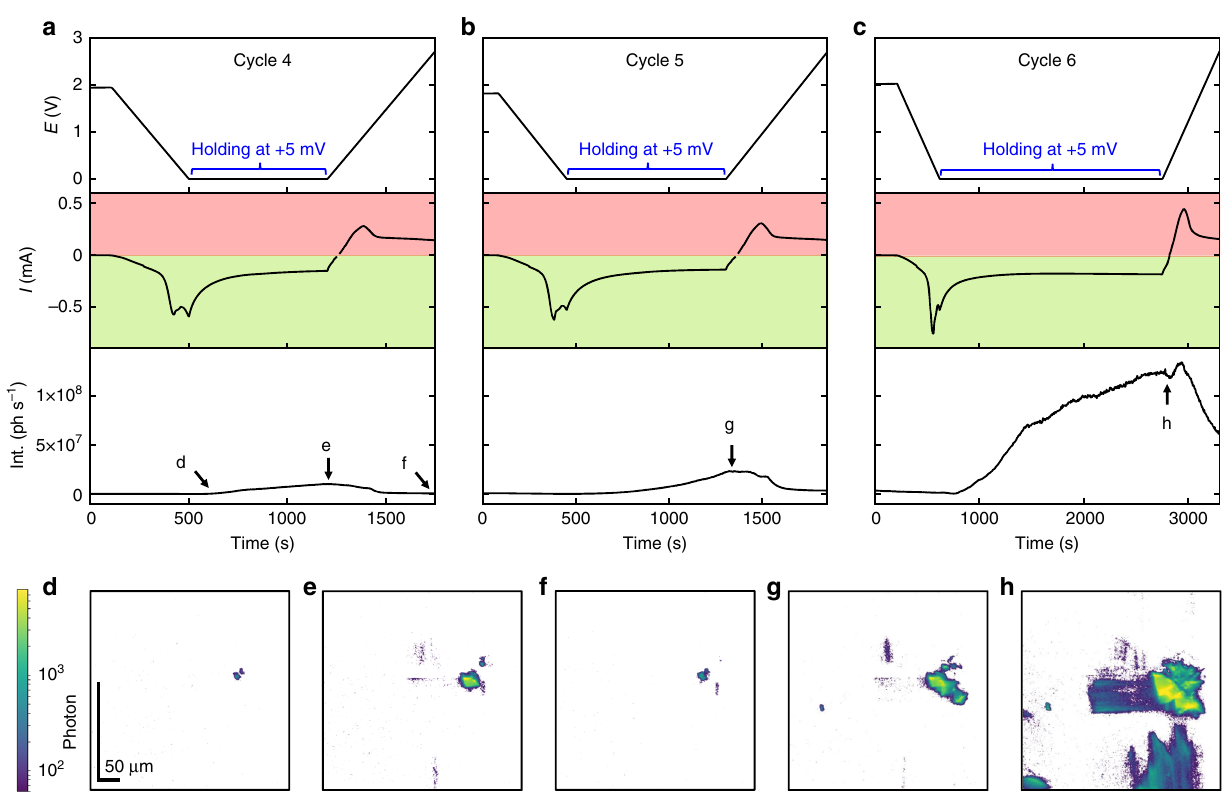
Fig. 4 Defect evolution from cycle 4 to 6. E , I, and Int curves of cycle 4 ( a ), 5 ( b ), and 6 ( c ). The light green and light red background illustrate the current range for lithiation (negative currents) and delithiation (positive currents), respectively. The labels of d – h match the marked annotations in a – c , corresponding to the instants of time at which the FFDXM images were